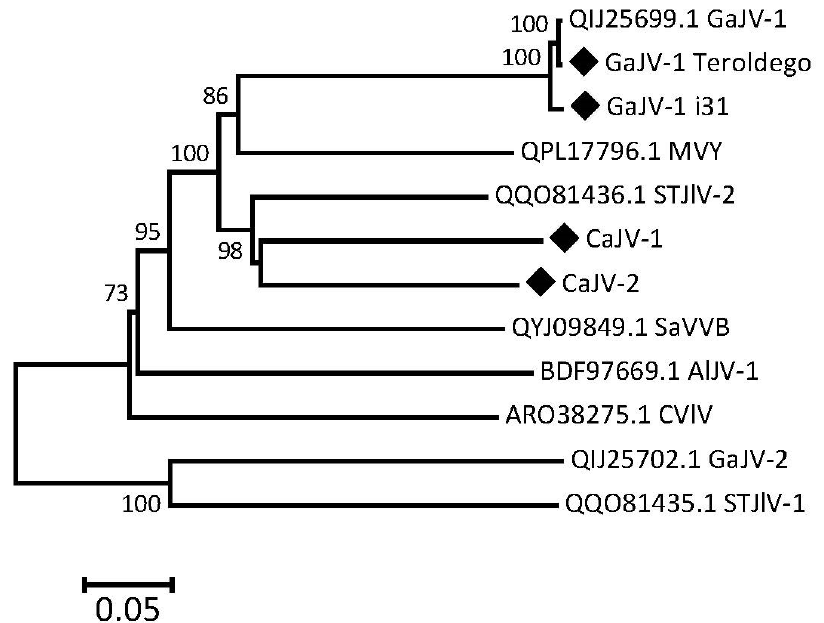
Figure 5. Phylogenetic tree reconstructed from the sequences of the P2 proteins of GaJV-1, CaJV-1 and selected related agents. The tree was reconstructed using the neighbor-joining method and strict amino acid distances. Branch validity was evaluated by bootstrap analysis (1000 replicates) and only bootstrap values > 70% are shown. Sequences determined here are marked by a black diamond. The scale bar represents 5% aa divergence. GaJV-1 (or -2): grapevine-associated jivivirus 1 (or -2); CaJV-1 (or -2): Carya-associated jivivirus 1 (or -2); CVlV: citrus virga-like virus; MVY; mastic virus Y; SaVVB: sisal-associated virgavirus B; AlJV-1: Aspergillus lentulus jivivirus 1; STJlV-1 (or -2): soybean thrips Jivi-like virus 1 (or -2).